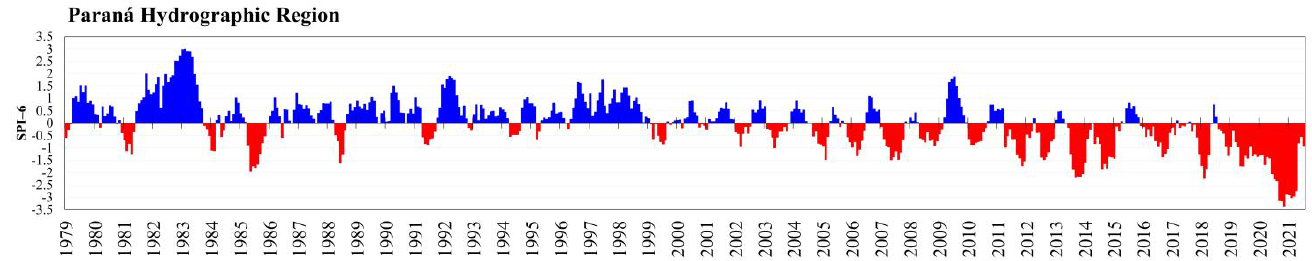
Figure 5. SPI-6 time series for PHR. Table 5. March SPI-6 values within the hydrological drought event (identified by SPI-12) from 2016 to 2021. The years marked in bold were characterized by moderate or extreme drought conditions (identified by